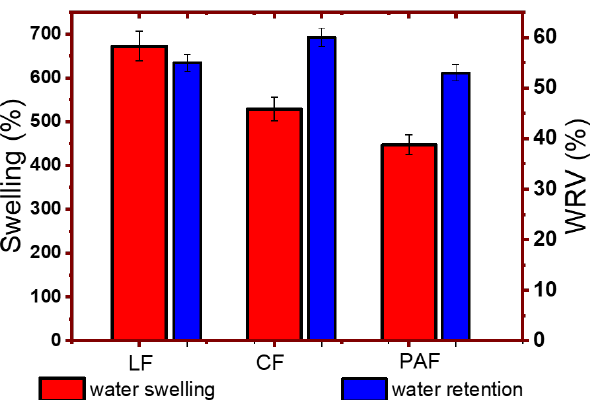
Figure 7. Swelling and water retention values (WRV; %) for linen fiber and its treated forms with an uncertainty of ±3%.